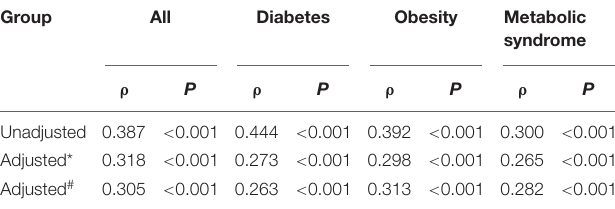
Spearman correlations. Significance (P-values) of rho coefficients ( ρ ) between serum FABP4 and FLI are reported in the whole population (all), diabetes, obesity, and metabolic syndrome patients (unadjusted). P-values corrected by age, gender (*) and by age, gender, glucose, triglycerides, apoA1, apoB100, and AST ( #